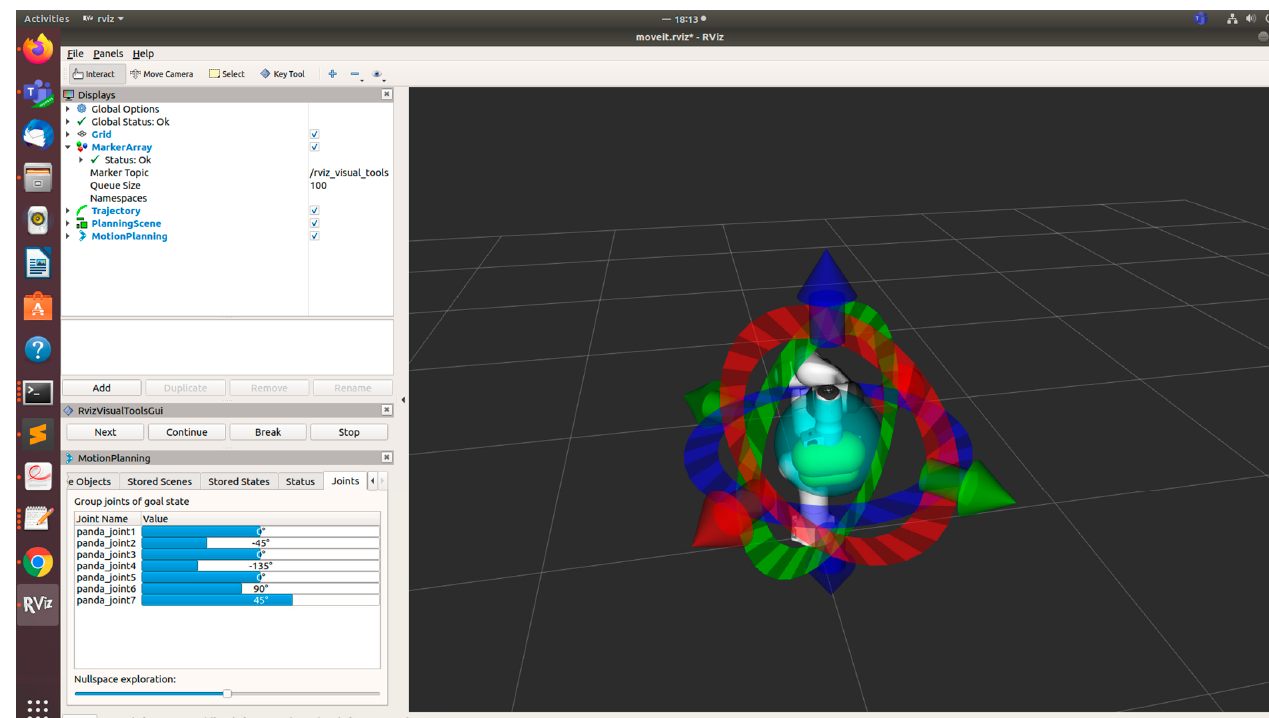
Figure 4. Screenshot of motion planning configuration displayed in RVIZ control panel.